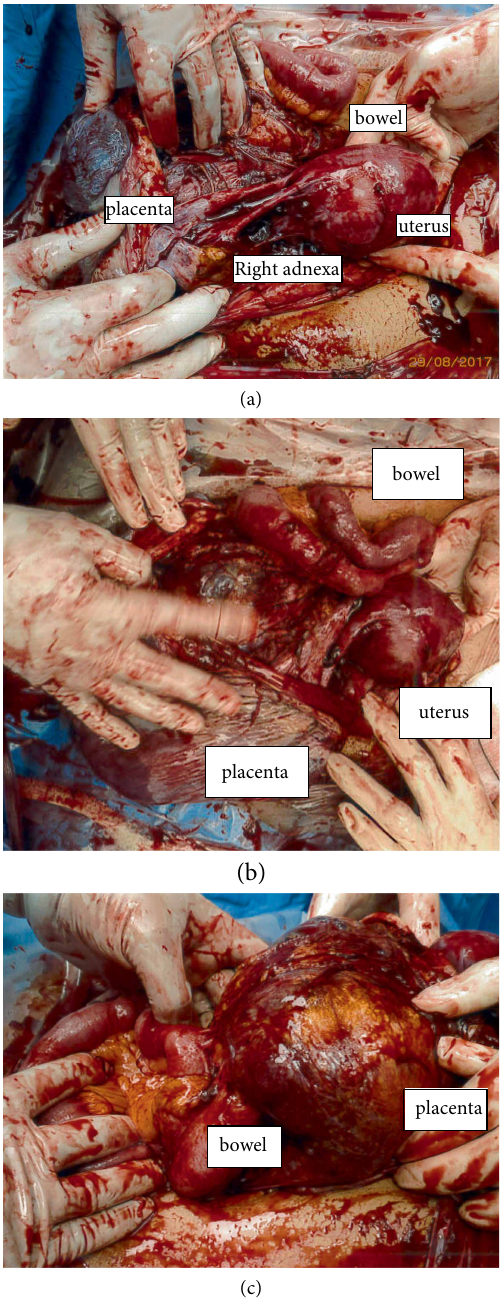
Figure 1: The placenta is located outside of the uterus, attached to the right adnexa, terminal ileum, proximal caecum, and